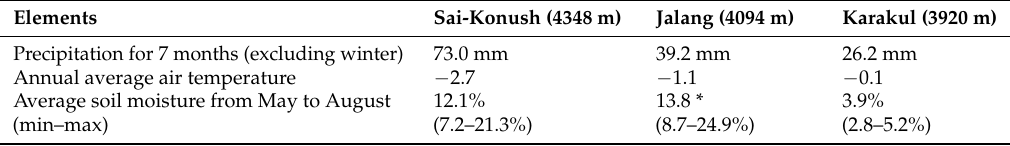
Table 1. The summary of the measured climatological data in Sai-Konush Jailoo, Jalang Jailoo, and the Karakul village from August 2014 to July